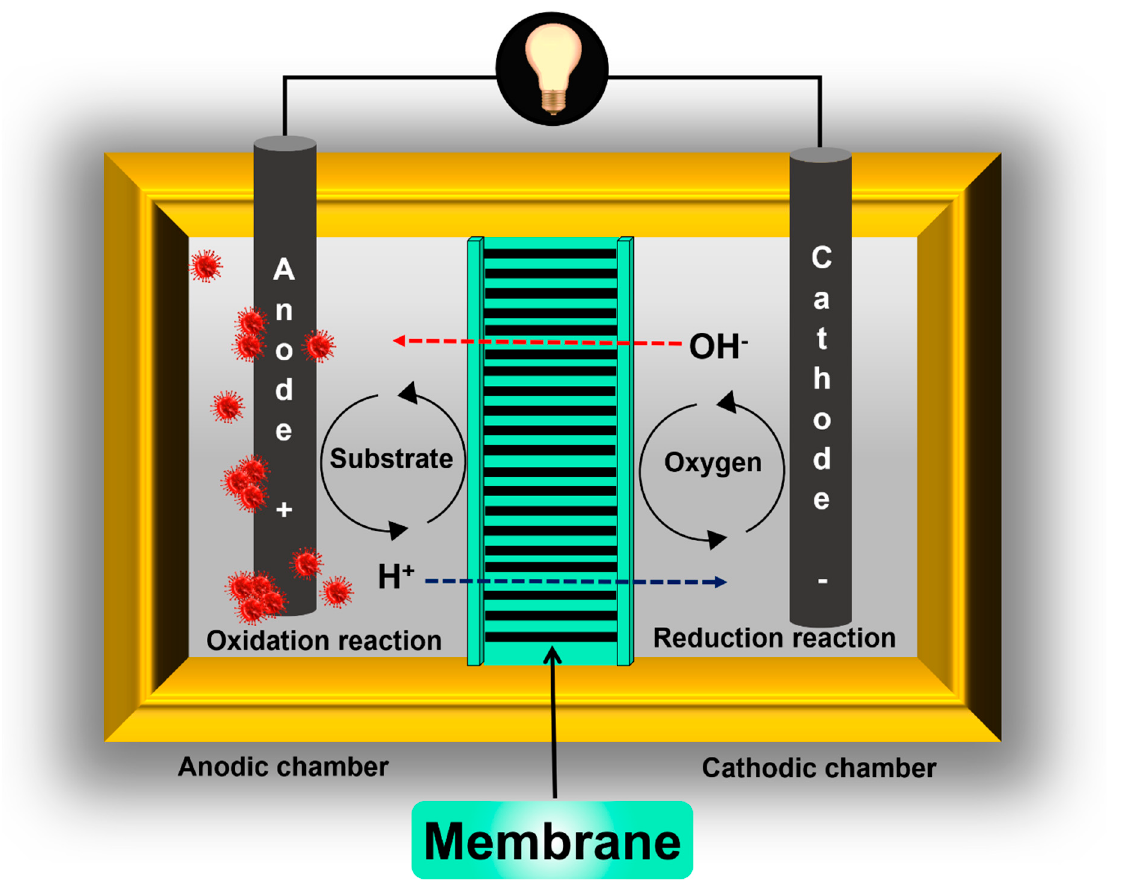
Figure 3. Membrane functions.